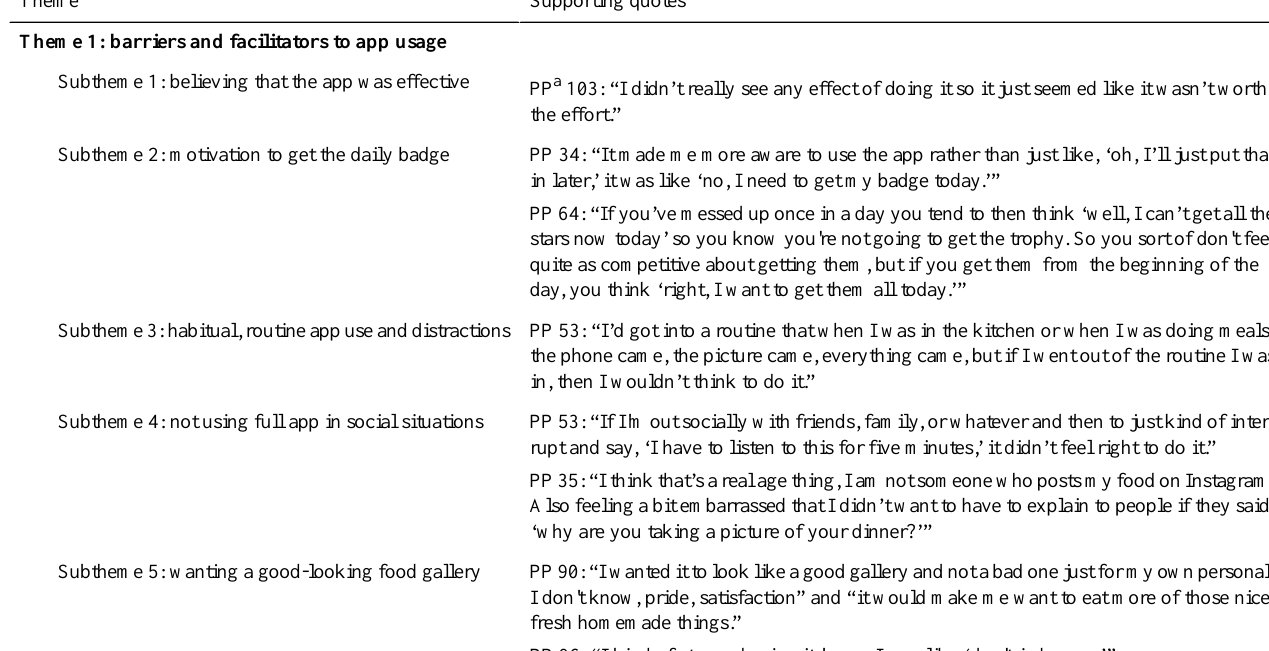
Table 2. Table of themes and supporting quotes. Theme 1: barriers and facilitators to app